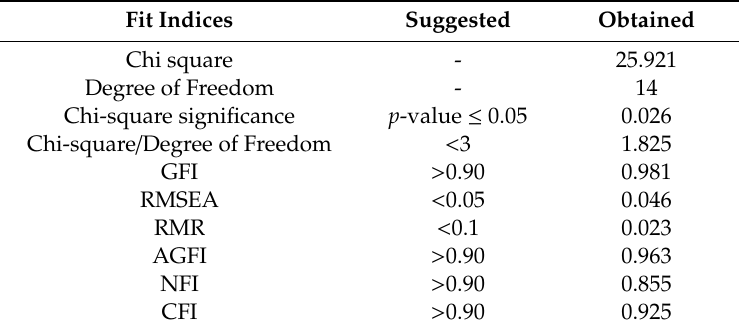
Table 16. Fit indices and their acceptable thresholds in